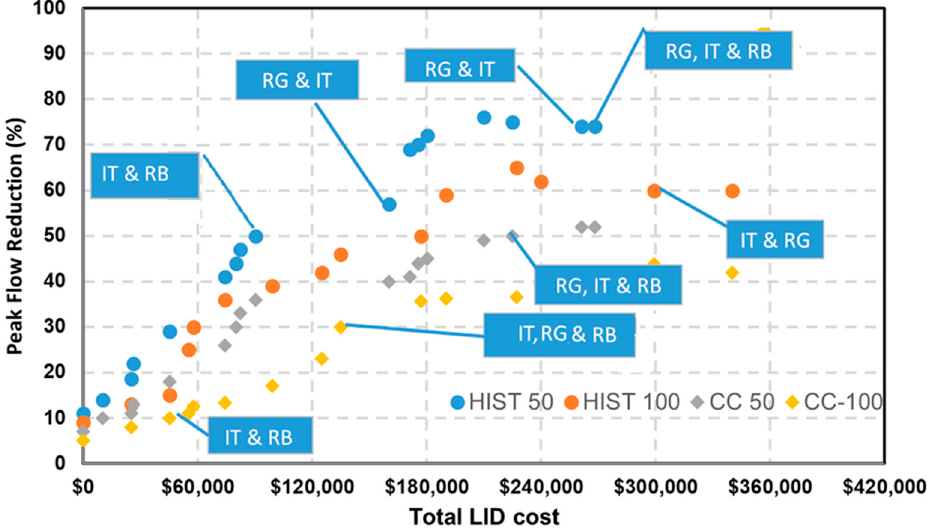
Figure 8 . Peak-flow reduction versus implementation costs for selected optimal design variables of LIDs.